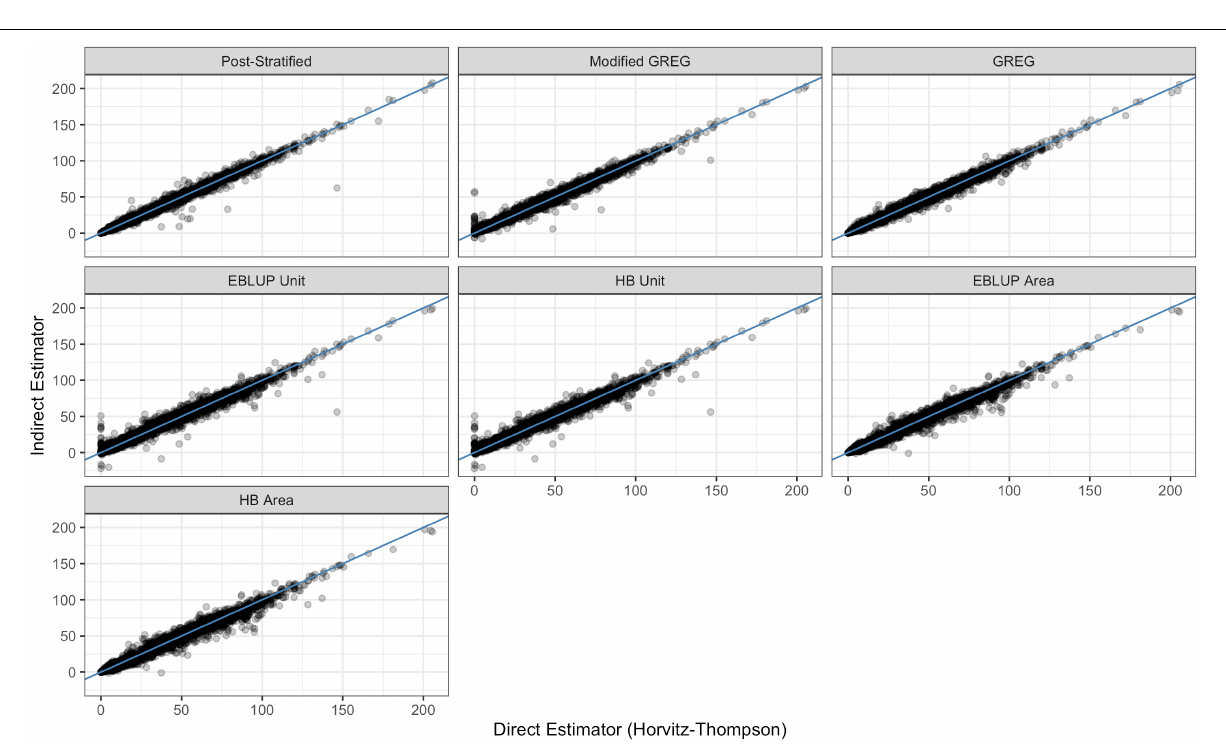
Frontiers in Forests and Global Change |